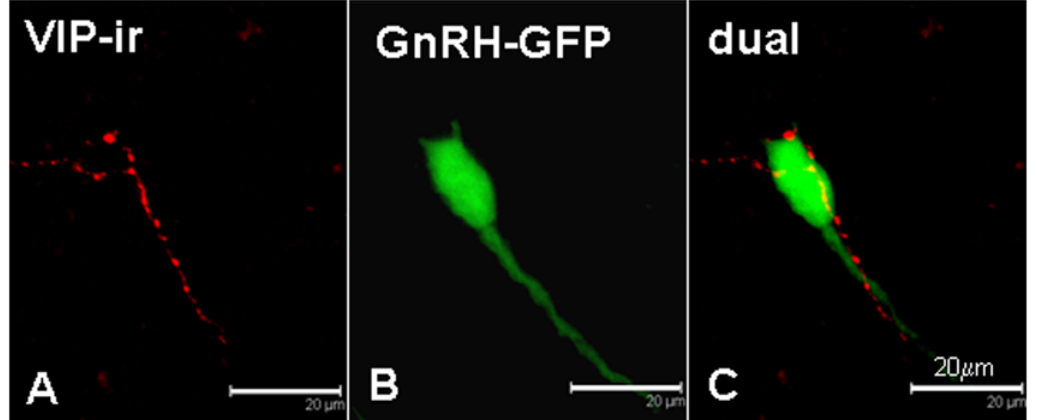
Figure 2. VIP-GnRH interactions. Confocal microscopy photomicrographs of 0.5 m m optical sections showing the relationship between a vasoactive intestinal polypeptide fiber ( A : VIP, red) and a GnRH-GFP perikaryon ( B : GnRH, green). Panel C shows the superimposed images. Scale bars=20 m m.